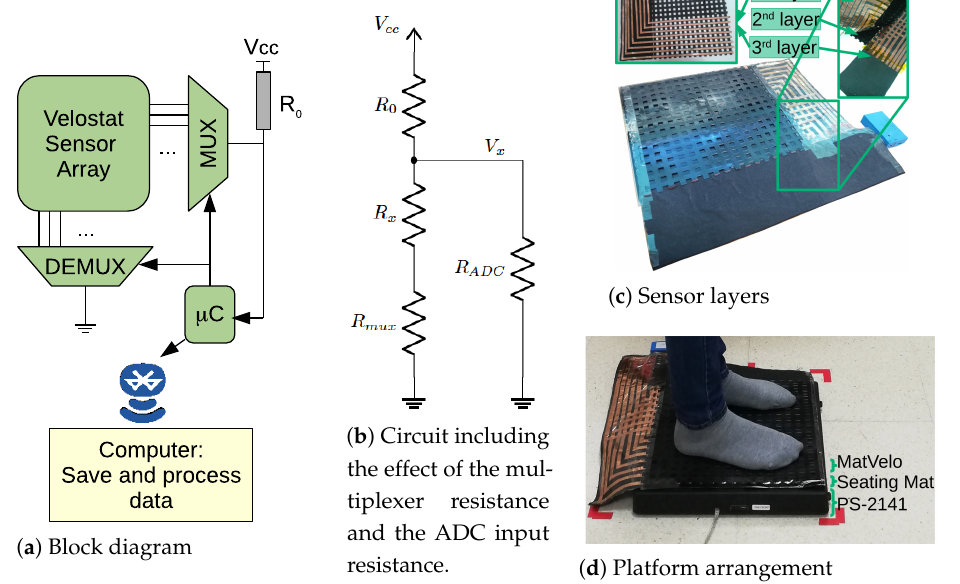
Figure 1. MatVelo PSM configuration and experiment setup with the commercial systems. ( a ) Block diagram of data-acquisition system; ( b ) equivalent circuit of each scanned cell; ( c ) layers of our custom-made PSM; ( d ) setup of the three overlapping